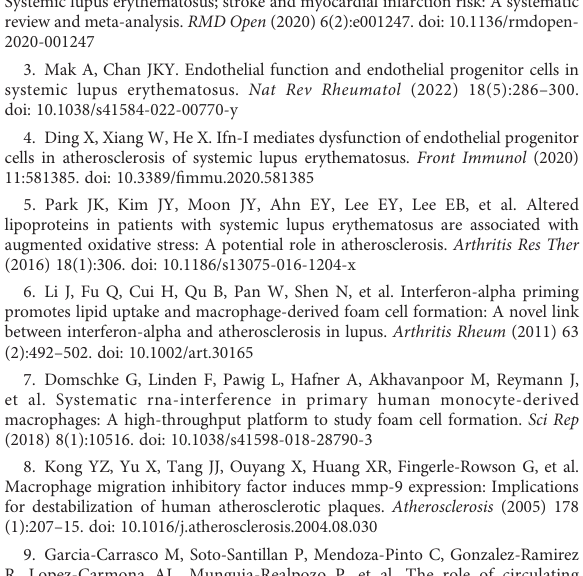
SUPPLEMENTARY FILE 1 The differentially expressed genes of GSE50772. SUPPLEMENTARY FILE 2 The differentially expressed genes of GSE100927. SUPPLEMENTARY FILE 3 The common differentially expressed genes. SUPPLEMENTARY FILE 4 The differentially expressed genes of